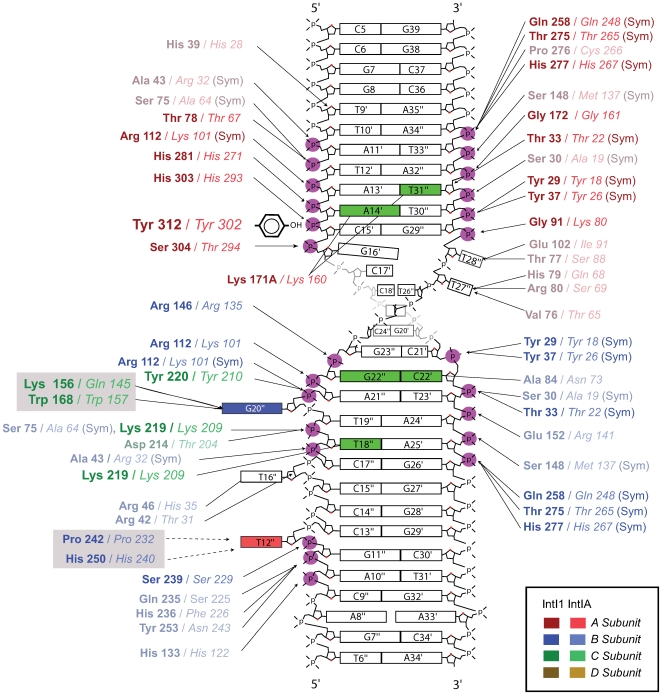
Schematic representation of the protein-DNA contacts between the IntI1 integrase and the VCRbs.IntI1 interactions with the VCRbs are derived from the model we previously made [31] based on the crystal structure of the VchIntIA –VCRbs complex [25]. The IntI1 amino acids (aa) are indentified by name (three letters code) and position, while the corresponding aa in VchIntIA are given in italics. The amino acids that are either not conserved between IntI1 and IntIA or among other sequenced integron integrases are faded. All hydrogen bonding protein contacts <3.5 Å are shown. Magenta circles depict protein-phosphate contacts and the position of base-specific hydrogen bonding is shown in green. The aa residues specifically involved in interaction with the EHBs G20″ (Ring stacking and hydrogen bonds) and T12″ (Stacking interactions between ring structures, dashed lines) are on grey backgrounds. The colour code for each IntI1/IntIA subunit is given in the inset. Contacts that are equivalent between the attacking and non-attacking interfaces are denoted by (Sym).